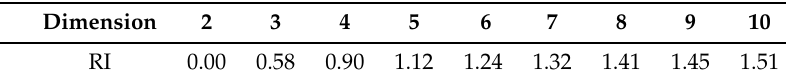
Table 2. Values of the random index